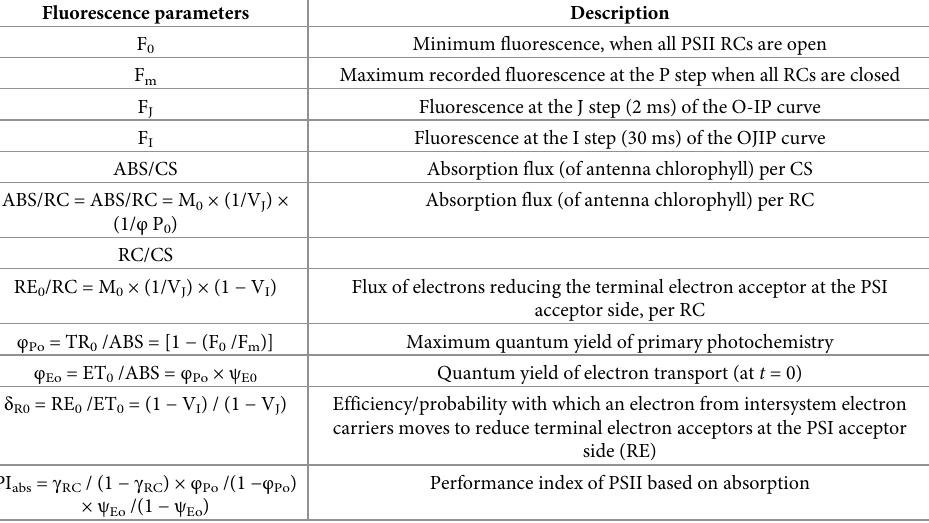
Table 2. Definitions of measured and calculated chlorophyll a fluorescence